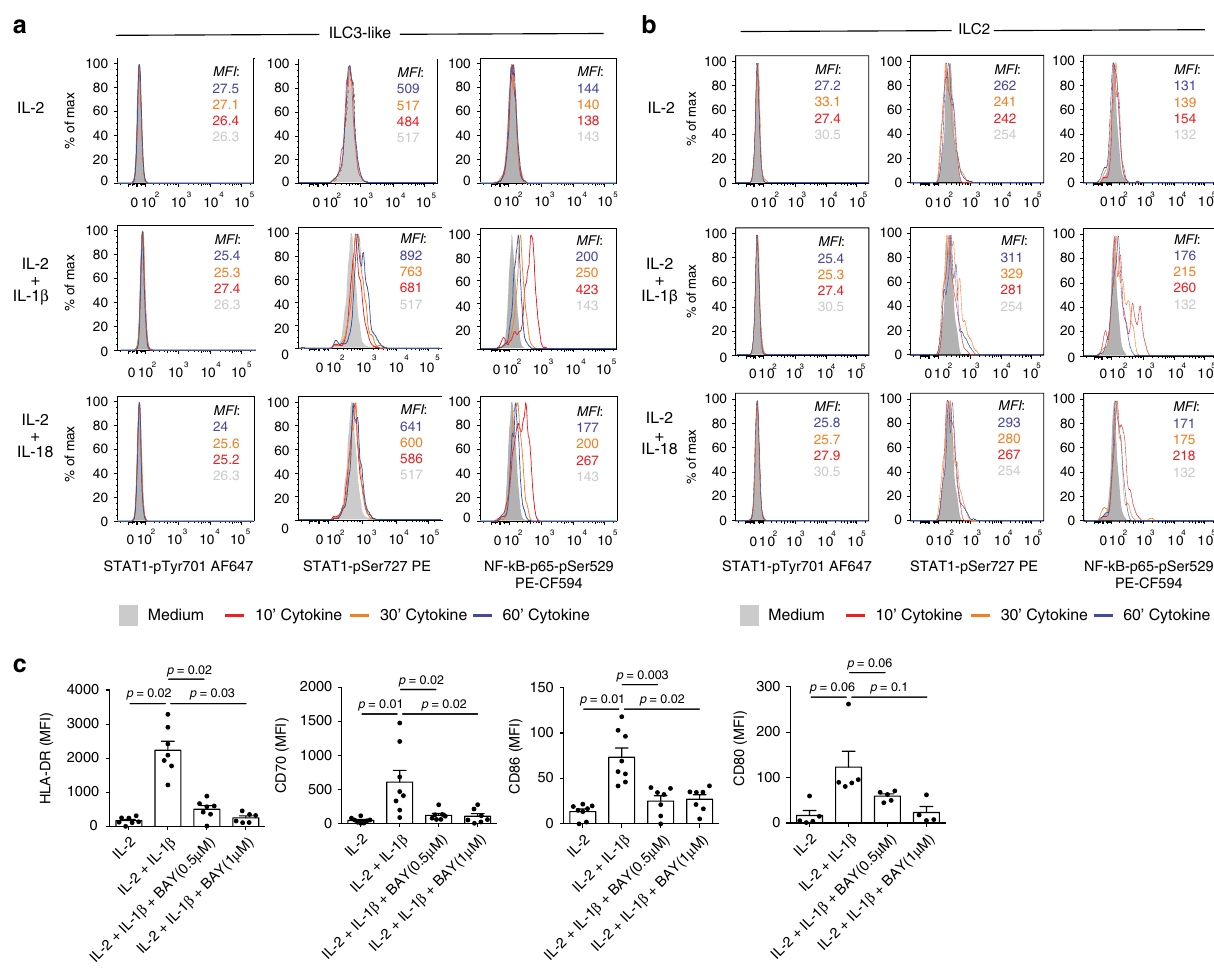
Fig. 5 Mechanism driving HLA-DR and co-stimulatory molecule upregulation on PB ILCs after IL-1 β or IL-18 treatment. a , b Flow cytometric analysis of STAT1 Tyr701 , STAT1 Ser727 , and NF- κ B-p65 Ser529 phosphorylation in sorted PB ILC3-like cells ( a ) and ILC2 ( b ) following 10, 30, or 60 min incubation with expression on sorted PB ILC3-like cells, following 72 h incubation with IL-2, IL-2 plus IL-1 β , or IL-2 plus IL-1 β in the presence BAY11-7082. N (donors) = 7 for HLA-DR, 8 for CD70 and CD86 and 5 for CD80; bars and error bars indicate mean and SEM; statistical signi fi cance was assessed using two-sided Wilcoxon matched-pairs signed rank test. Source data are provided as a source data fi conclusion, IL-1 β and/or IL-18 stimulation of PB ILC3-like cells leads to NF- κ B signaling, which, at least in the case of IL-1 β , is needed for optimal HLA-DR and co-stimulatory molecule expression.